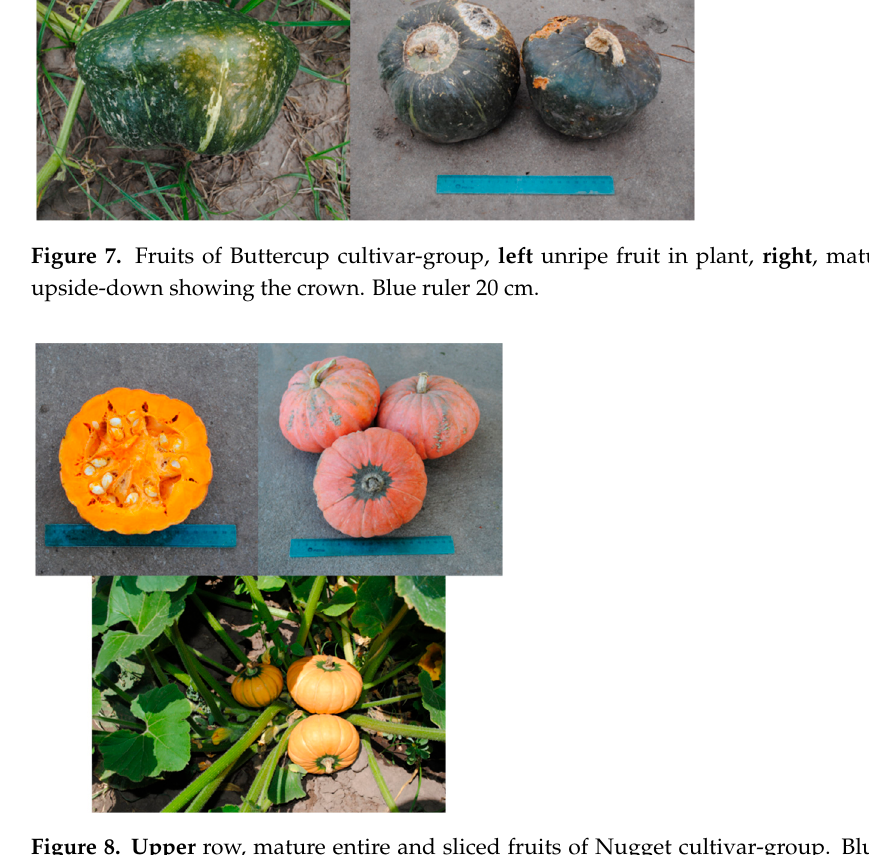
Figure 8. Upper row, mature entire and sliced fruits of Nugget cultivar ‐ group. Blue ruler 20 cm. Lower row, typical semi ‐ bush plant bearing immature